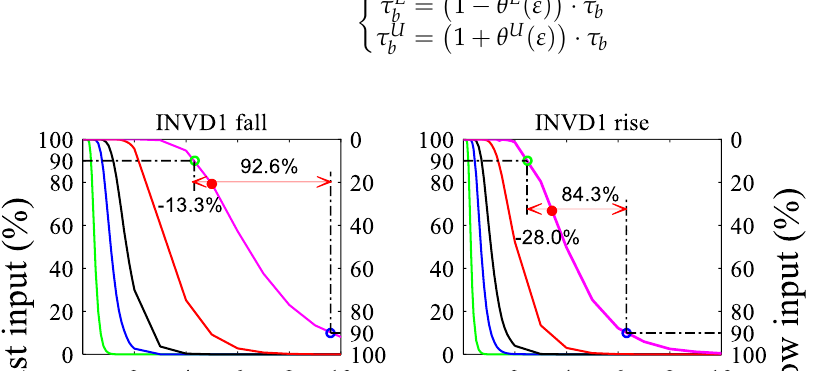
(12) Figure 4 verifies the accuracy of Equation (12) for different gates and driver strengths. As the mean of gate step delay increases, the standard deviation increases with the slope